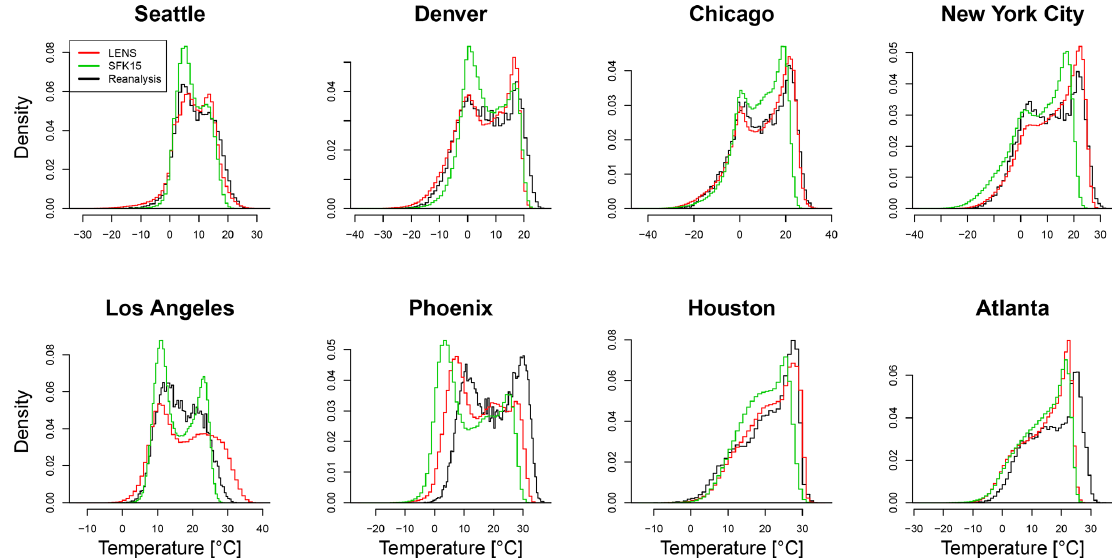
Figure 1. Comparison of marginal distributions of daily mean temperatures in LENS and SFK15 ensembles and ERA-Interim reanalysis. We show data for the whole year during the time period